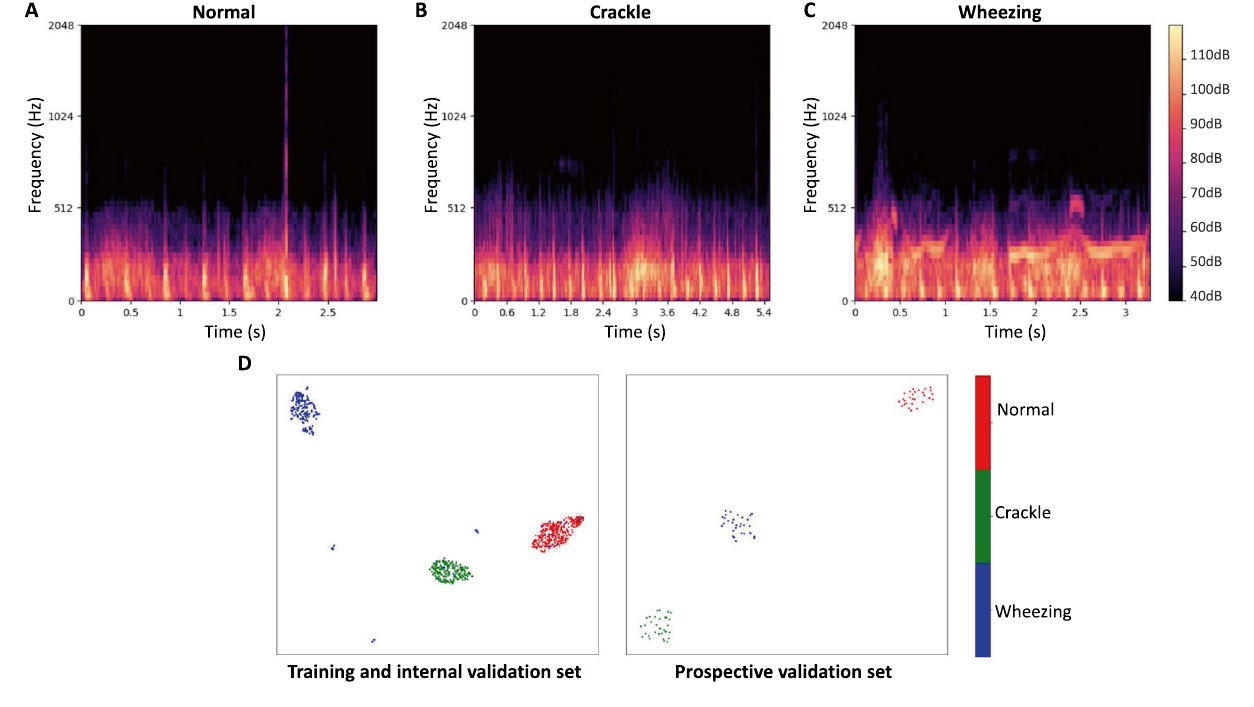
Figure 2. Typical mel-spectrograms labeled as normal ( A ), crackles ( B ), and wheezing ( C ), and UMAP visualization of lung sounds ( D ). ( A ) The typical normal lung sound mel-spectrogram exhibits homogeneous power intensity at ~ 200 Hz, mainly during inspiration and early expiration. ( B ) Crackles are characterized by multiple short, high-intensity bursts over a wide frequency, around 200–300 Hz, mainly during inspiration. ( C ) Wheezing is characterized by continuous musical sounds of narrow frequency bands, above 200 Hz. ( D ) The three classes of lung sounds are projected into three clusters by using UMAP for both the training and internal validation set and the prospective validation set. UMAP uniform manifold approximation and projection.